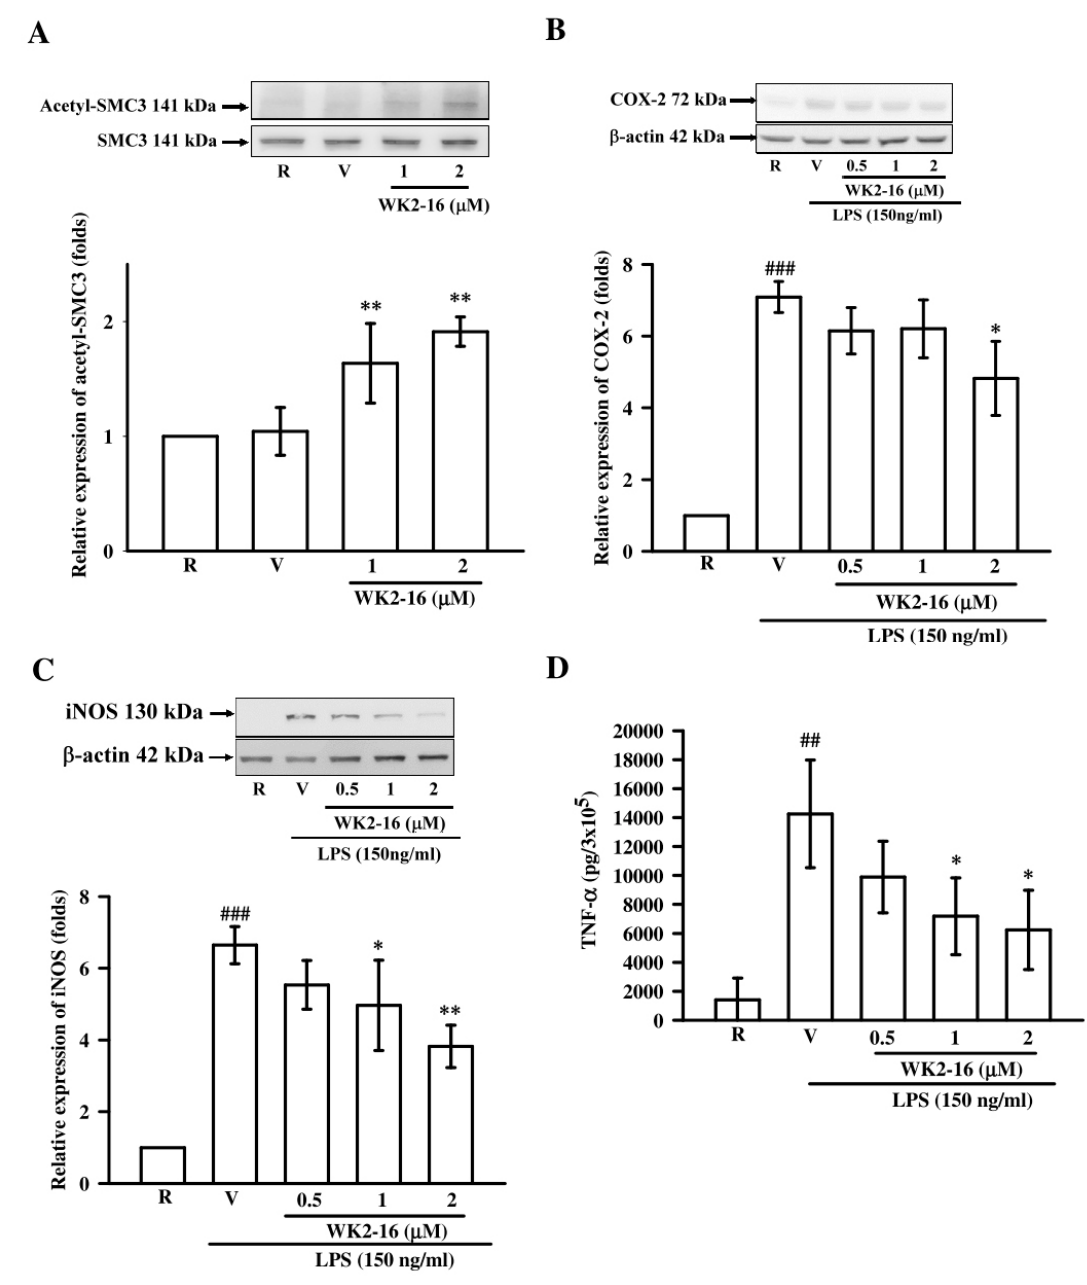
Figure 4. WK2-16 decreased inflammatory enzymes and TNF- α production in LPS-stimulated BV-2 microglial cells. ( A ) BV-2 cells were incubated with WK2-16 for 2 hours, and the acetylation level of SMC3 was determined using Western blotting. ( B,C ) BV-2 cells were pretreated with vehicle (DMSO) or WK2-16 (0.5, 1, and 2 μ M) for 30 minutes followed by LPS (150 ng/mL) stimulation for 24 hours. The expression of COX-2 and iNOS in LPS-stimulated BV-2 cells in the presence or absence of WK2-16 was examined using Western blotting. β -actin was used as the internal control. ( D ) TNF- α levels in conditioned media of cultured BV-2 microglial cells were measured using ELISA. Values are presented as the means ± SD from three independent experiments. R: resting; V: vehicle. ## p < 0.01, ### p < 0.001 compared to the resting group; * p < 0.05, ** p < 0.01 compared to the LPS-stimulated group treated with vehicle (DMSO).